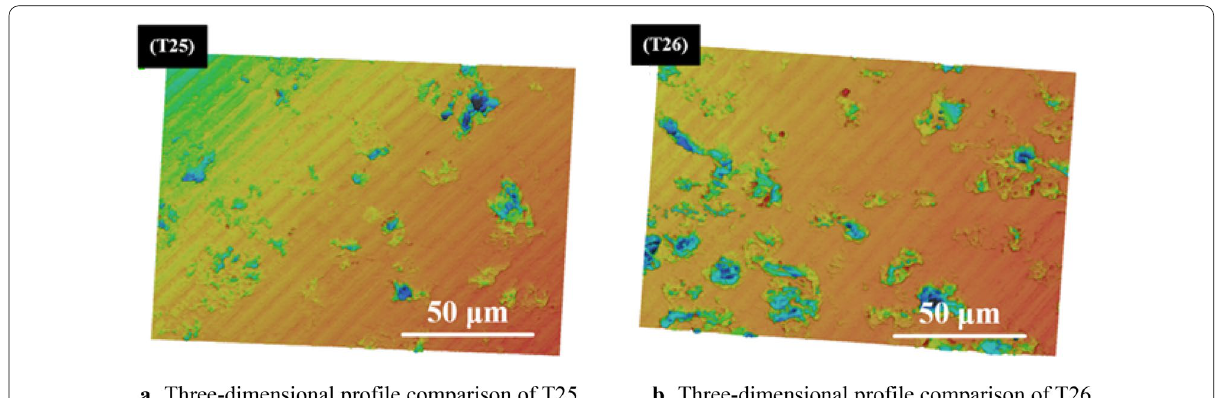
Figure 10 Three-dimensional profile comparison of T25 and T26